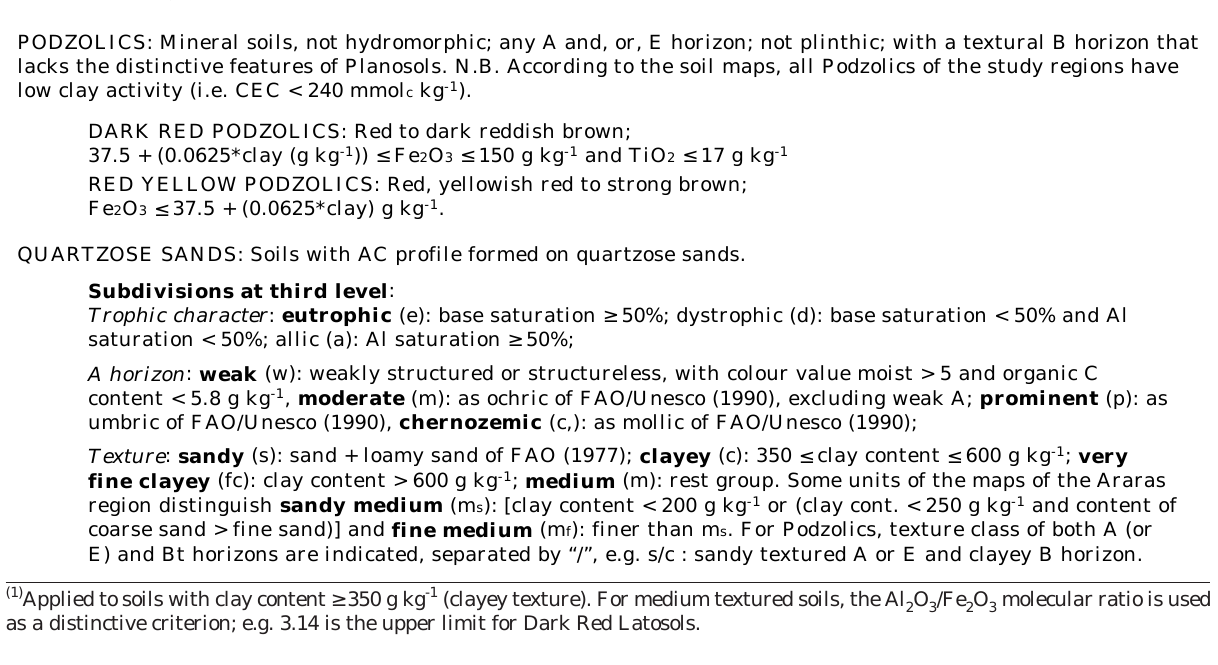
Soil classes at first two hierarchical levels LATOSOLS : Mineral soils, not hydromorphic, with latosolic B horizon following any diagnostic A horizon. Subdivisions according to type of latosolic B. DUSKY RED LATOSOLS : Dusky red to dark reddish brown (B horizon with hue redder than 4YR, value £ 3, chroma £ 6); related to high content of Fe 2 O 3 (180-400 g kg -1 ) (1) , strong magnetic attraction,